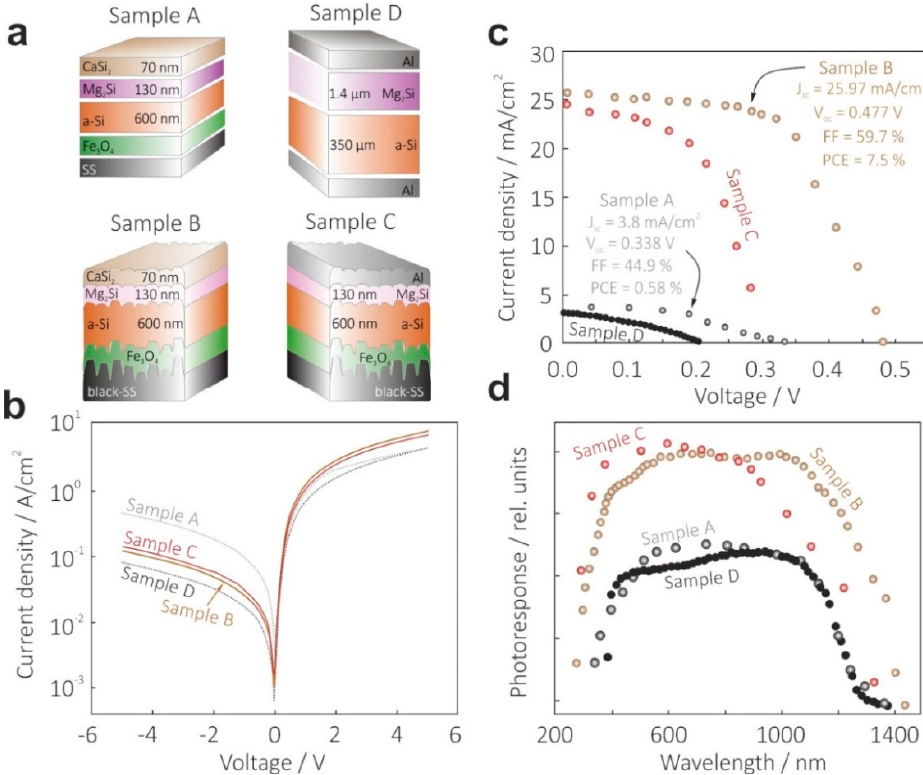
Figure 5. Photovoltaic performance of prototype Mg 2 Si/Si SC devices with flat and textured design. ( a ) Schematic presentation of solar cell devices with specified layered structure and thickness. ( b , c ) J-V curves measured under dark and AM1.5 conditions, respectively. ( d ) Room-temperature photoresponse spectra under zero-bias conditions.